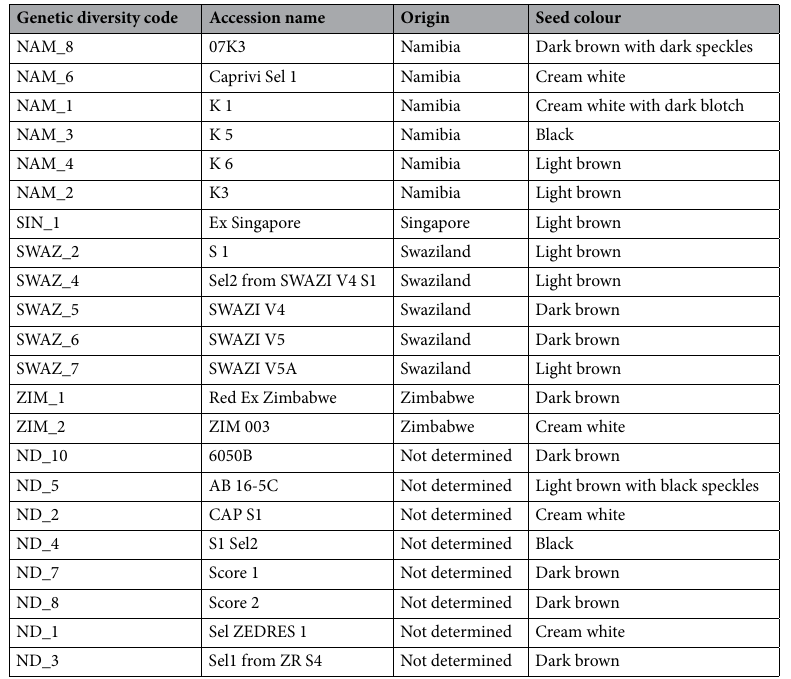
Table 1. List of Bambara groundnut accessions used for genetic diversity analysis.